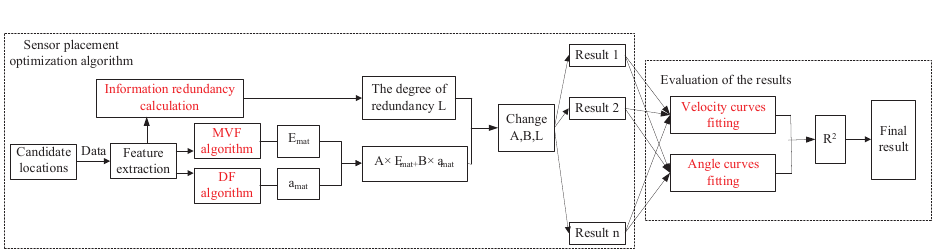
Figure 4. Sensor placement optimal